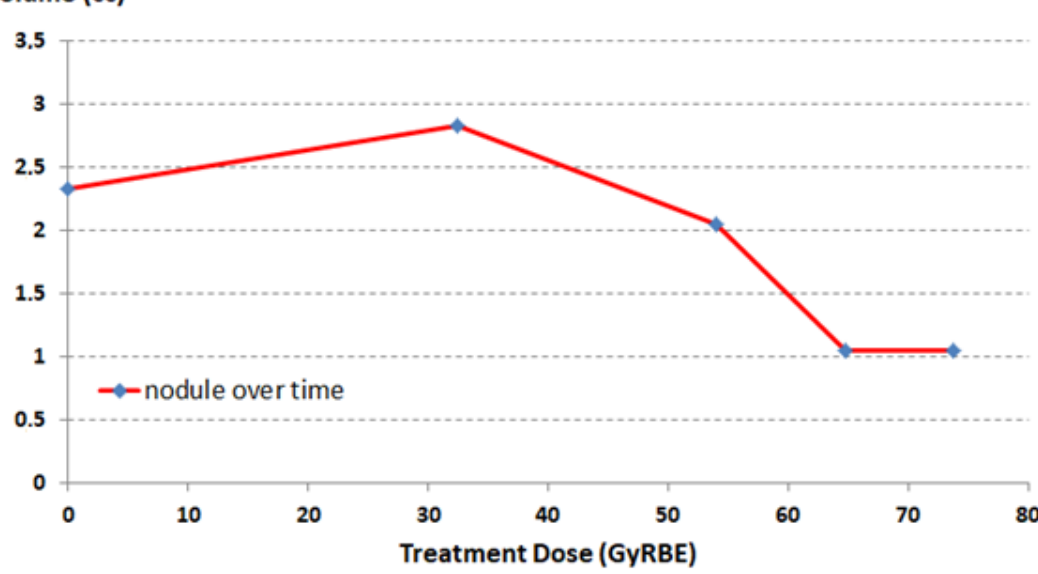
Figure 5. The plot shows the nodule component reduction over proton treatment course.